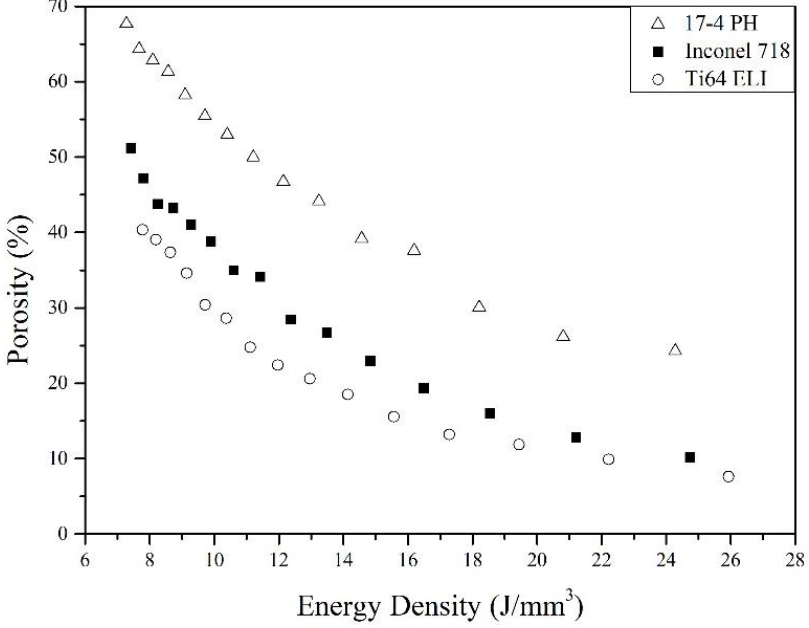
Figure 3. Relation between porosity and volumetric energy density ( ED v ) of the three alloys.